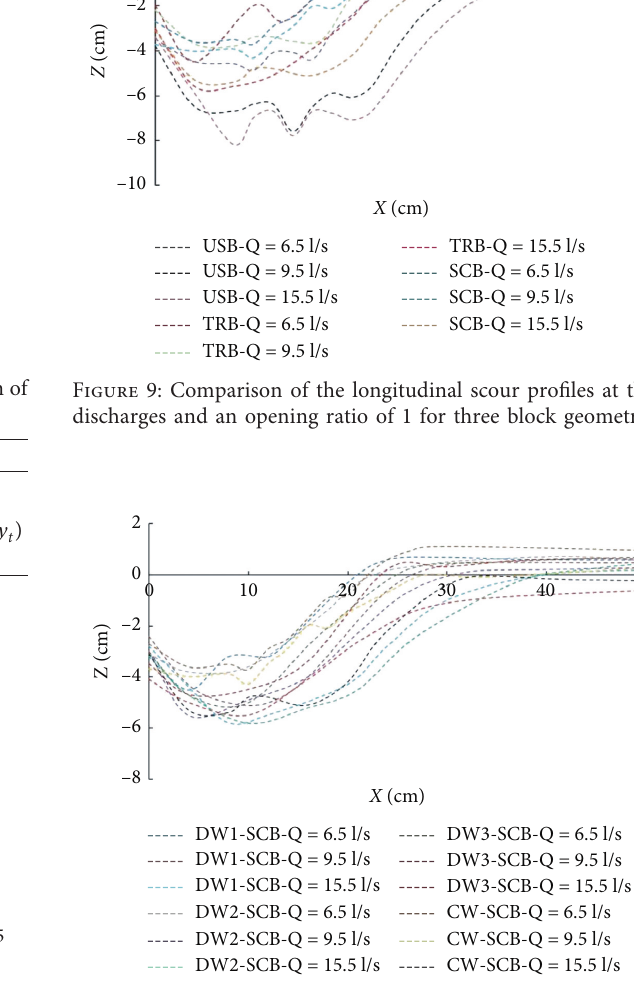
Figure 10: Comparison of the longitudinal scour profiles at three discharges and opening ratios for a semicircular